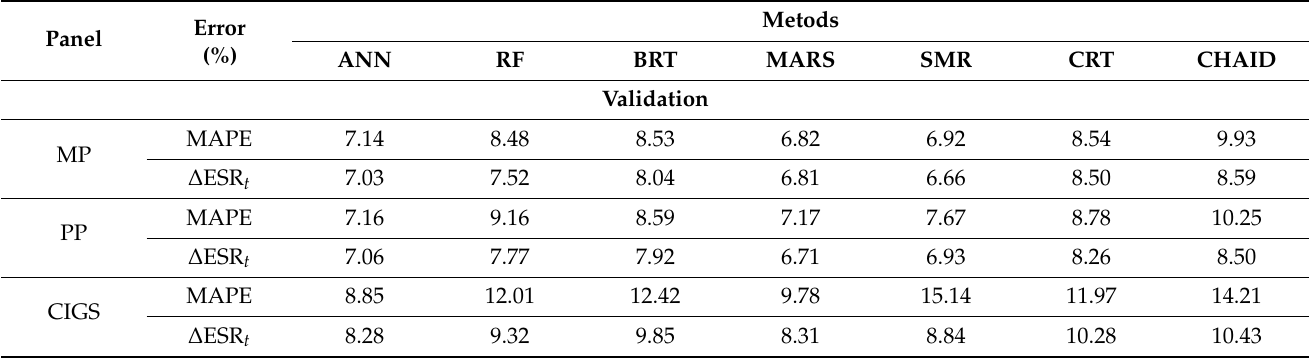
Table 1. List of errors for the used methods of modelling energy yield from PV panels, where the independent variable was the intensity of solar radiation and the cell operating